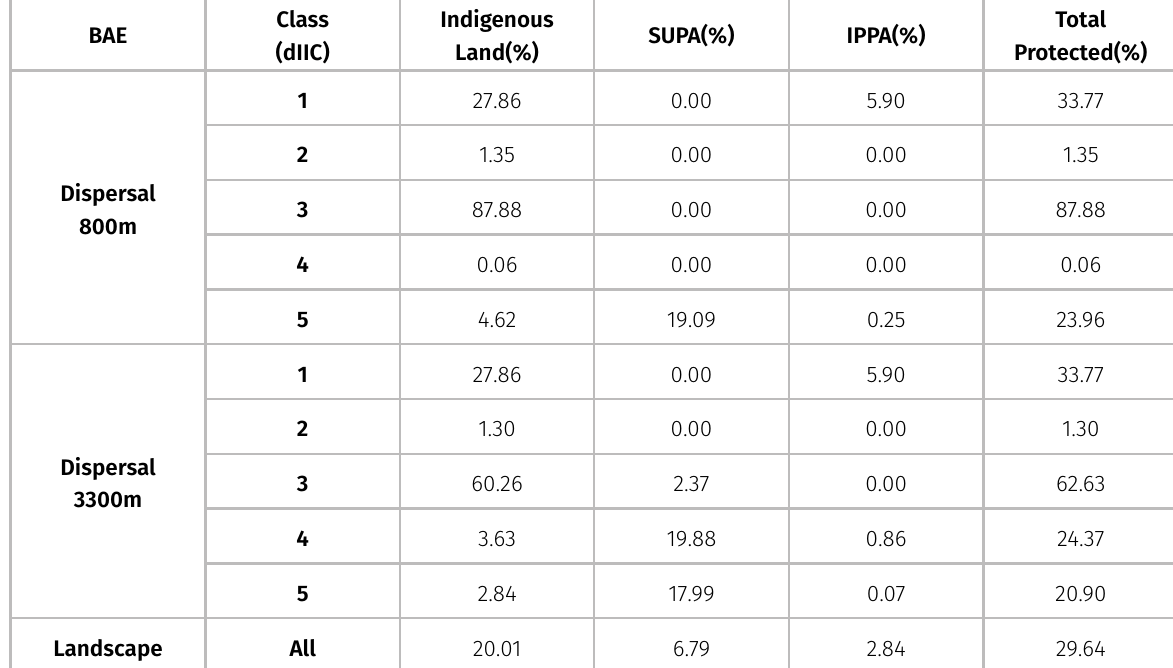
Total Protected(%)